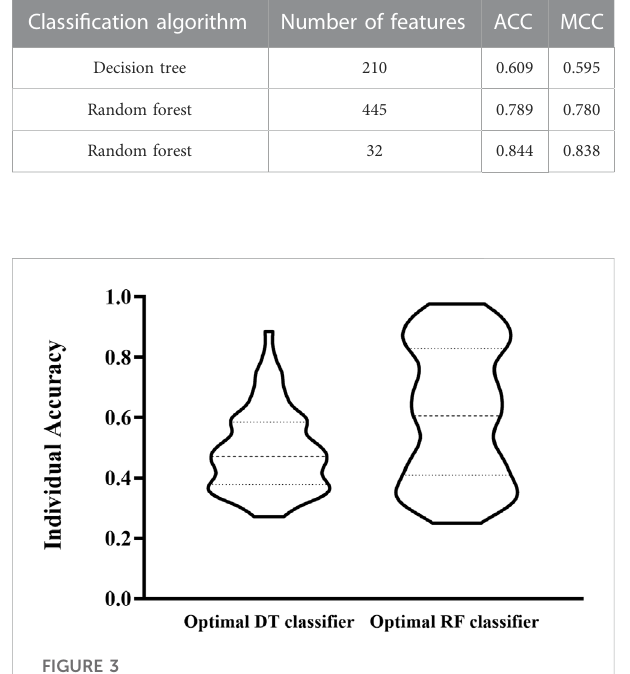
Similar to Figure 2, the IFS curve was plotted, as shown in Figure 5. The detailed IFS results are shown in Supplementary Table S5. The optimal RF classi fi er was constructed with MCC of 0.838 using the top 32 features in the feature list. The ACC of this classi fi er was 0.844 (Table 1). Compared with the previous optimal RF classi fi er (MCC = 0.780 and ACC = 0.789, see Table 1),